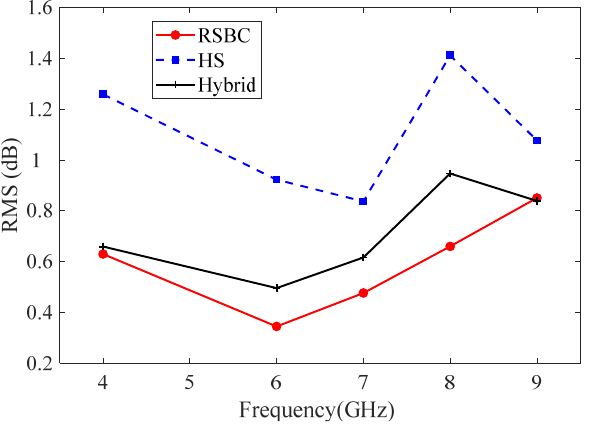
Figure 8. RMS as a function of operating frequency with size r=4.5 mm.